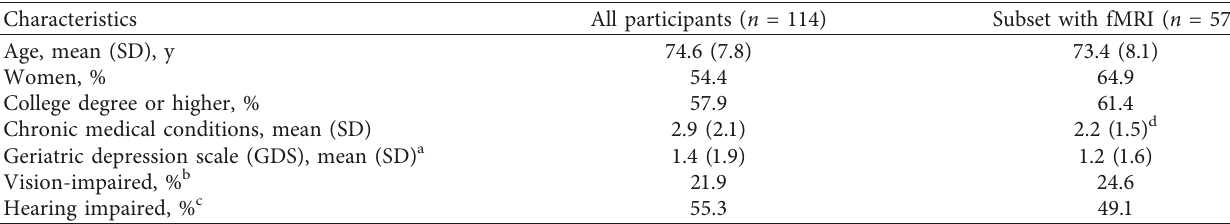
Table 2: Participant demographics and clinical